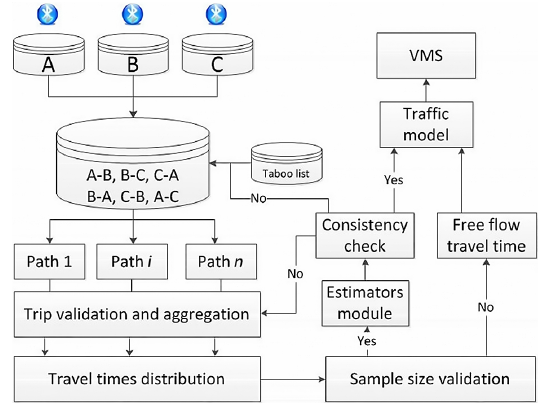
Fig. 7. Methodological flowchart